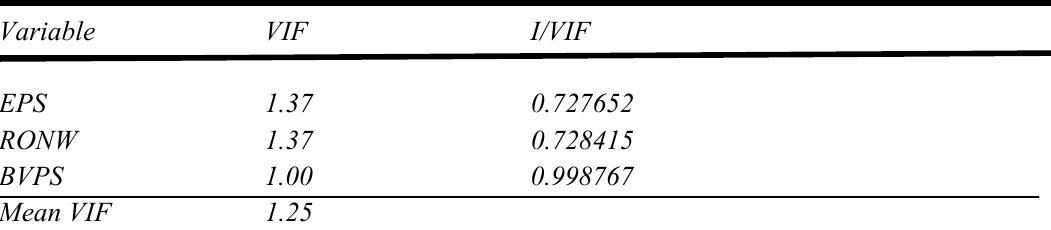
Table 2. Variance inflation factor